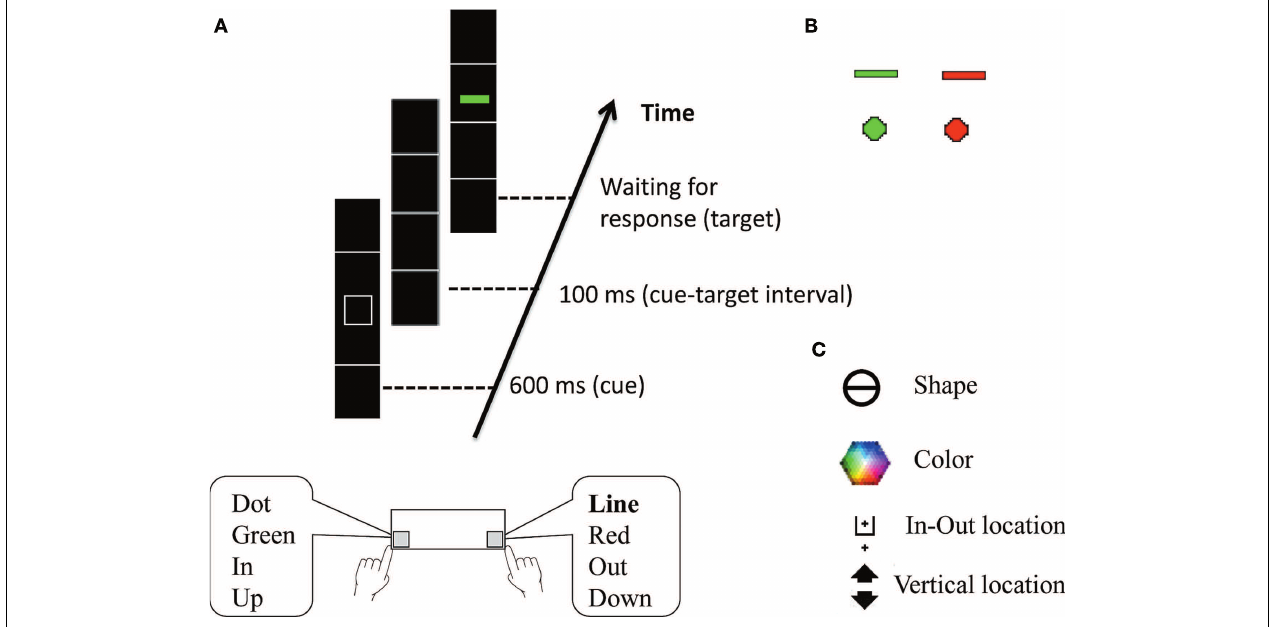
FIGURE 1 | Illustration of theVertical Boxes paradigm, based on Meiran et al. (2011a). (A) Schematic representation of the events in a trial, including cue presentation, followed by target presentation; ( B) the four target objects; ( C) the cues for the four